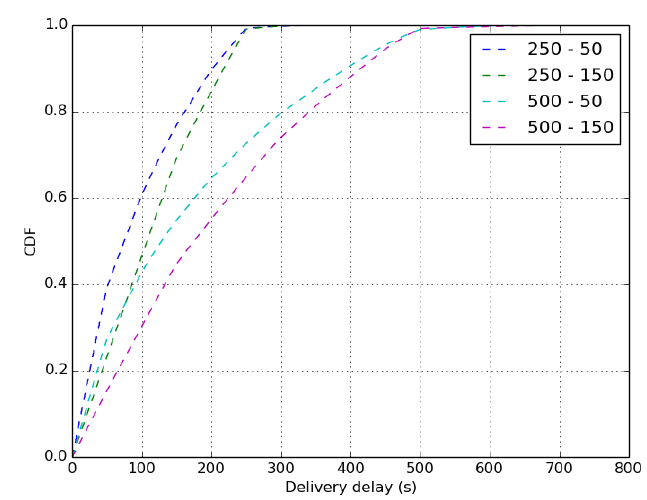
Figure 44. Loss rate.